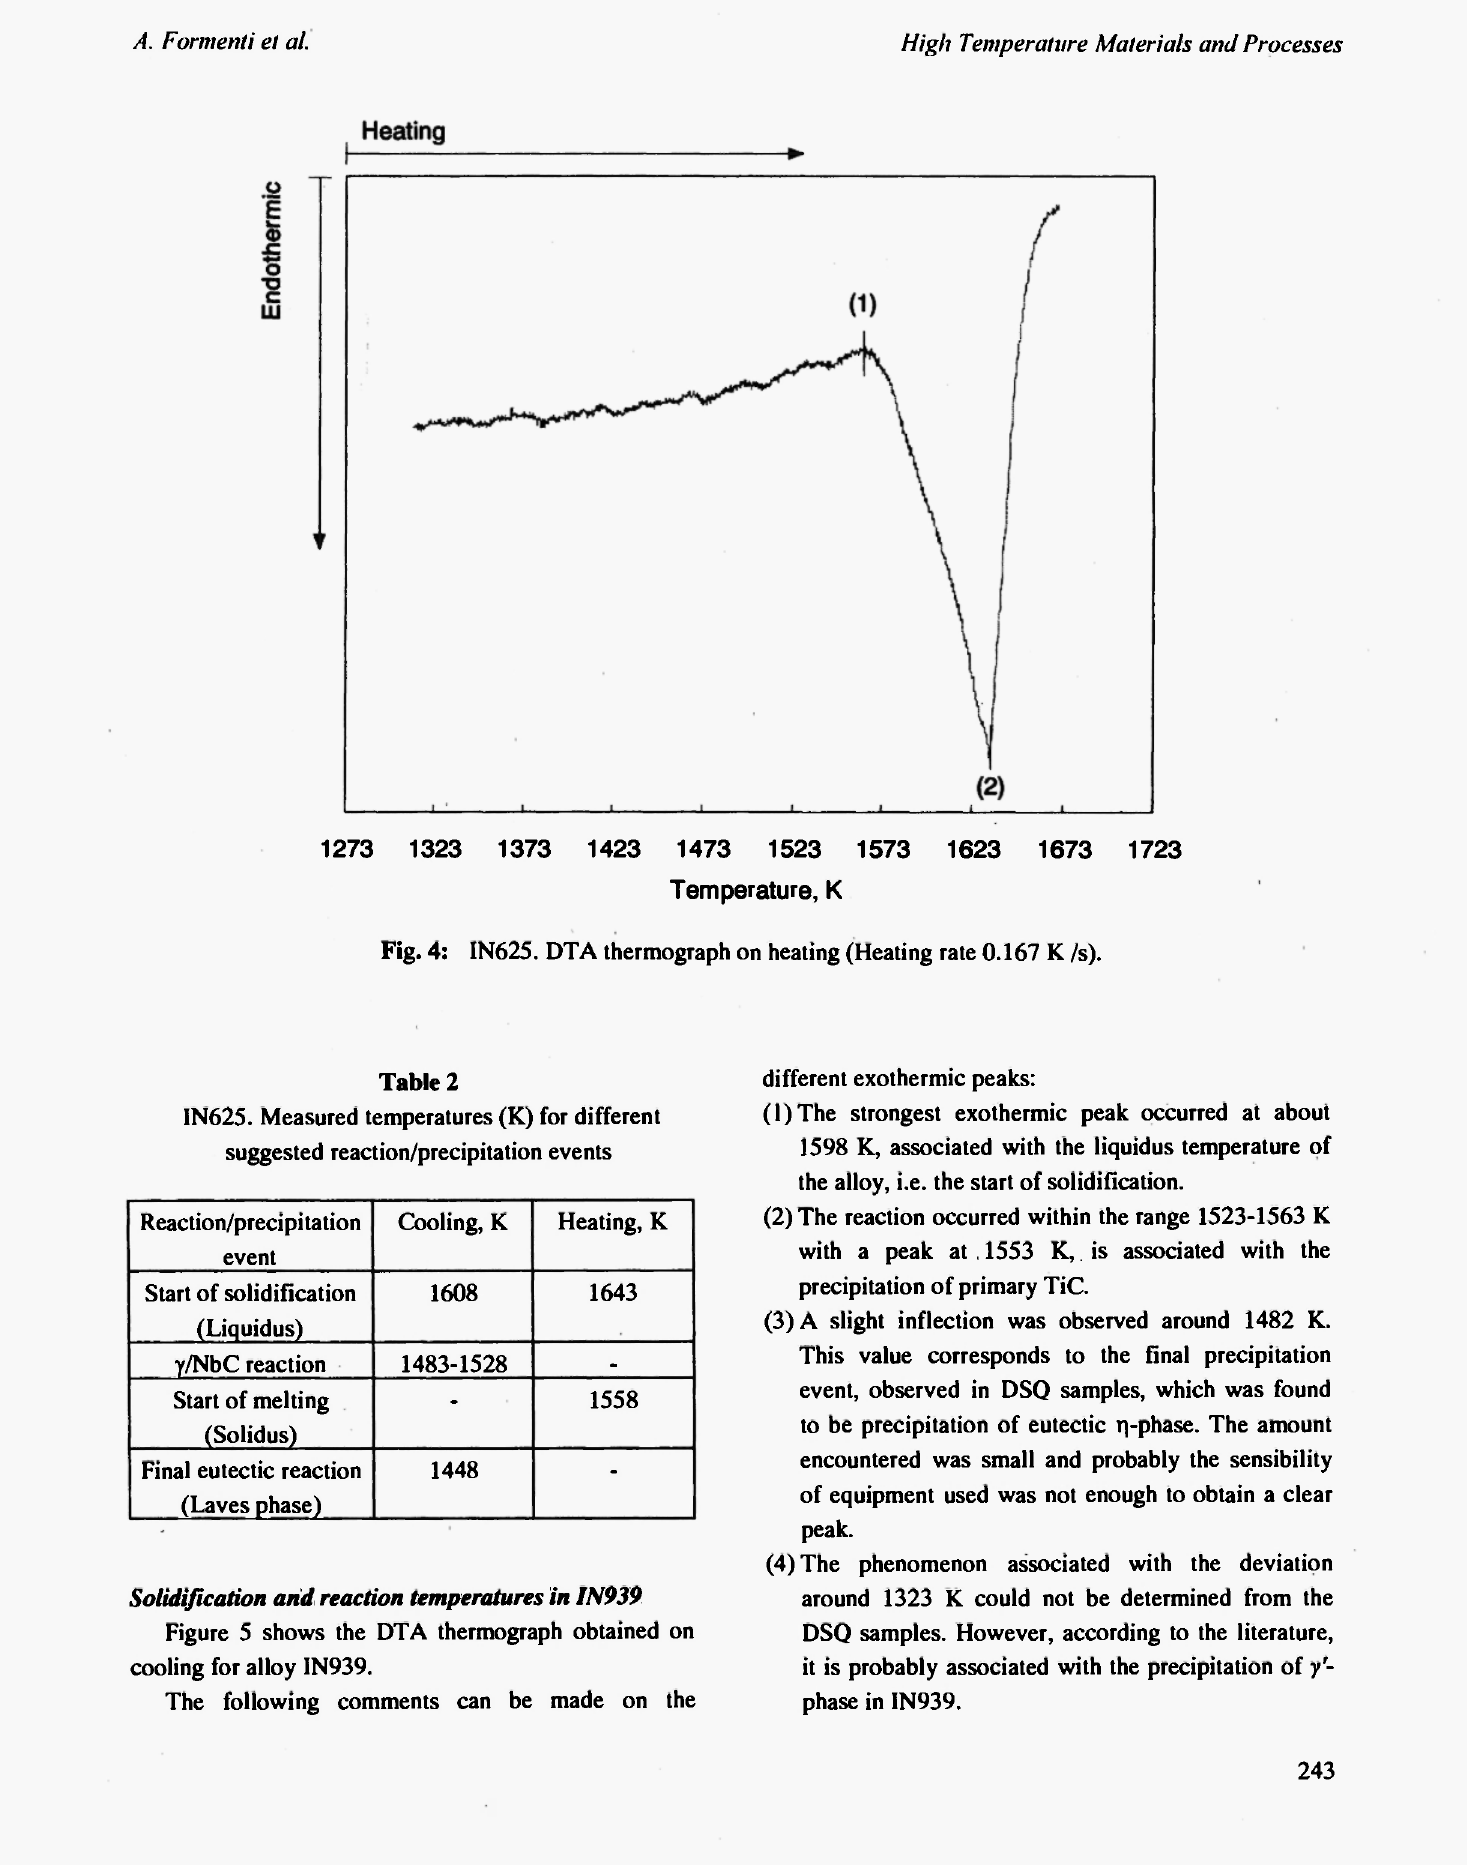
IN625. Measured temperatures (K) for different suggested reaction/precipitation